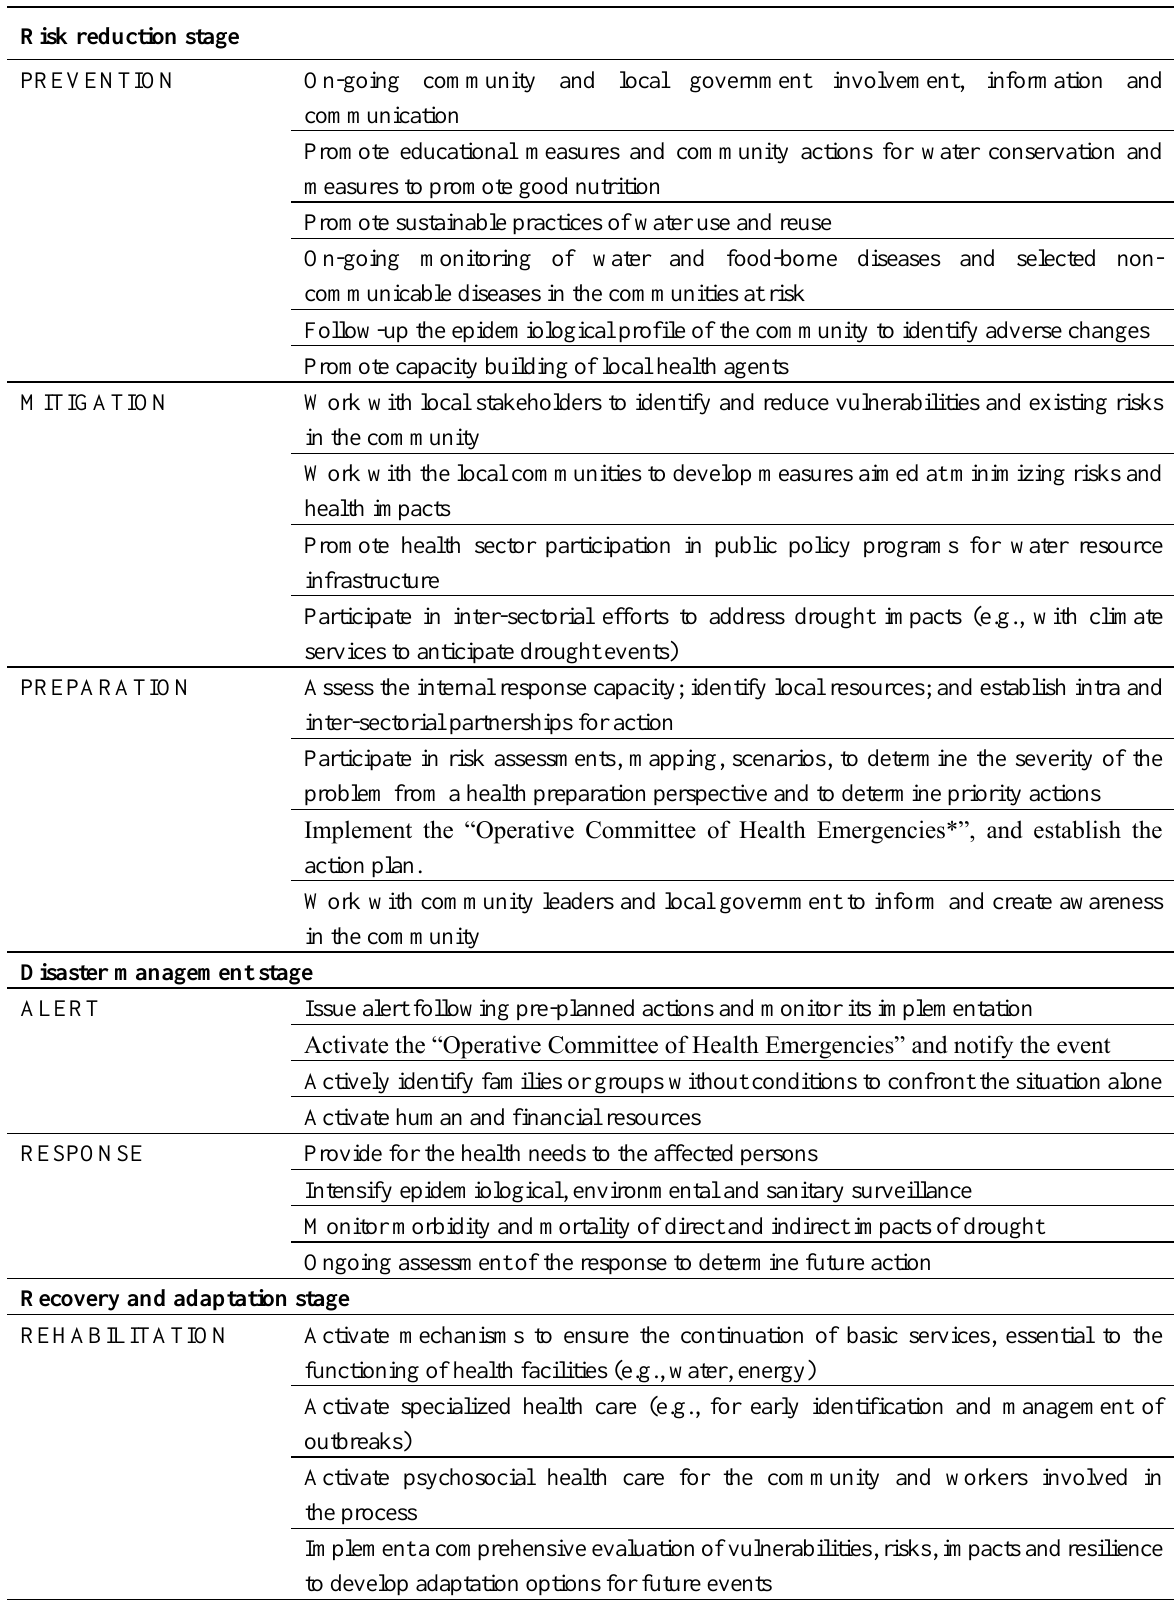
Table 2. Drought risk management by the health sector in